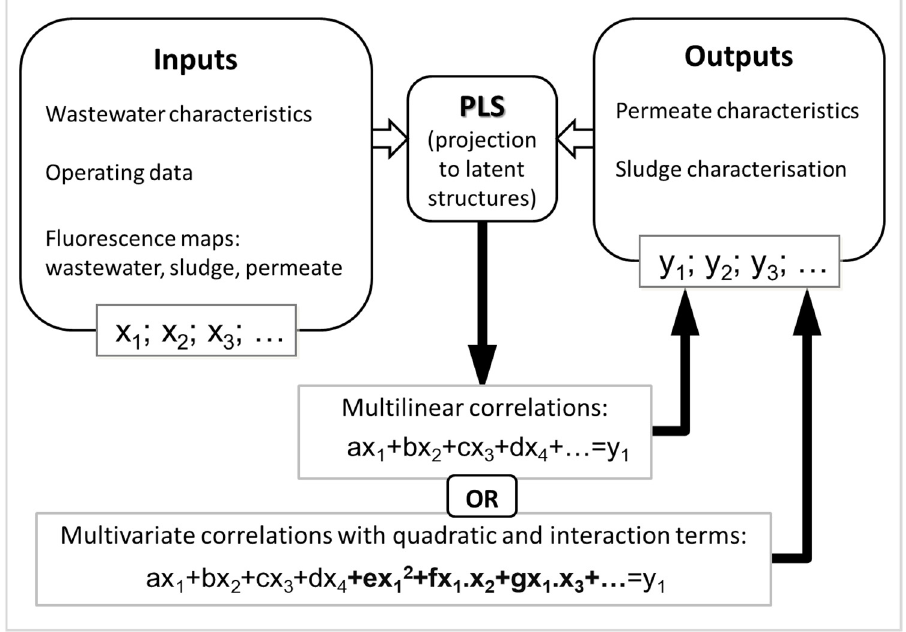
Figure 3. Schematic representation of PLS modeling methodology applied to MBR monitoring.